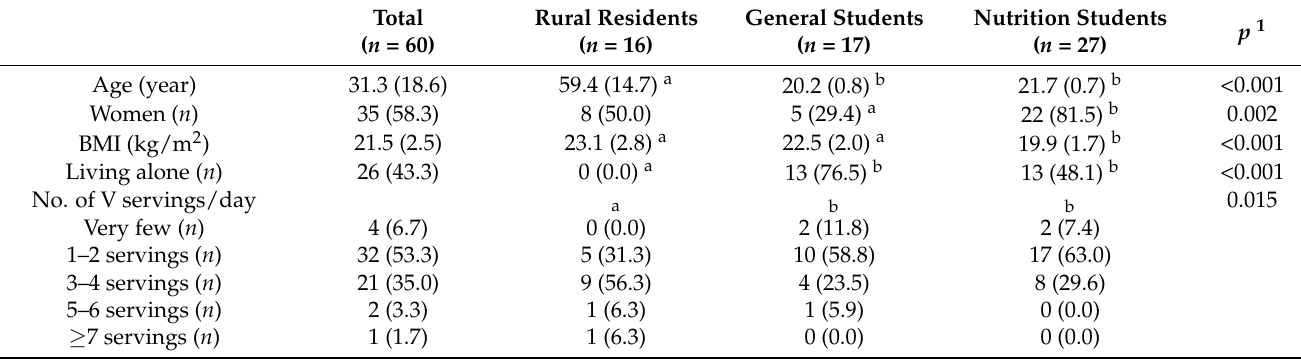
Table 2. Sociodemographic characteristics of the participants ( n =